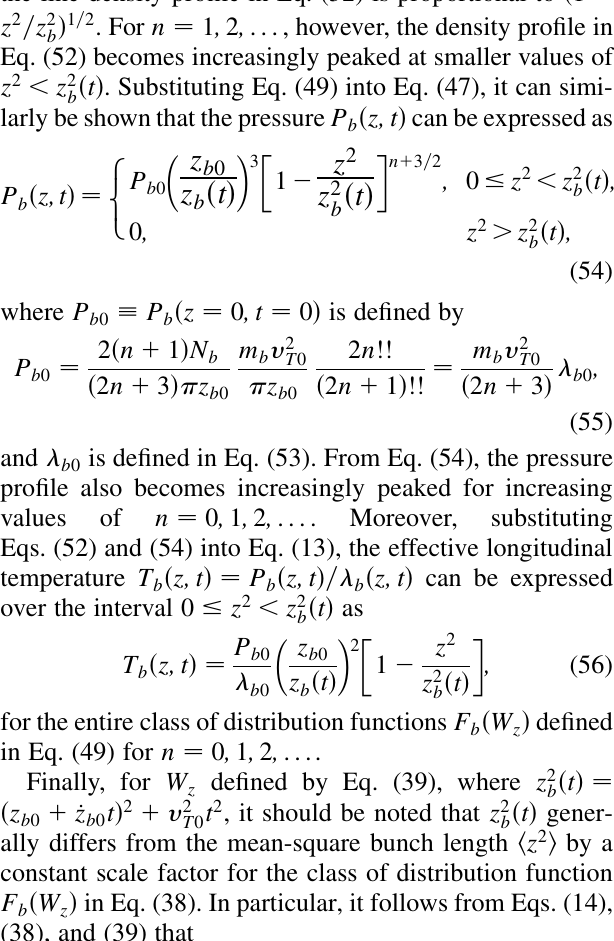
(cid:4) 1 rotates counterclock- < 0 , the ellipse W FIG. 2. For _ z b 0 z (cid:2) from its initial position at t (cid:4) 0 . wise in the phase space (cid:1) z; v z The ellipse becomes vertically aligned and slows to a stop at t (cid:4) t (maximum axial compression), and then rotates clockwise for f t > t . For t (cid:24) t , the ellipse expands indefinitely along the f f (cid:4) 1 remains z axis. Throughout its dynamics the ellipse W z (cid:2) (cid:4) (cid:1) 0 ; 0 (cid:2) and has constant area "z v centered at (cid:1) z; v z b 0 T 0